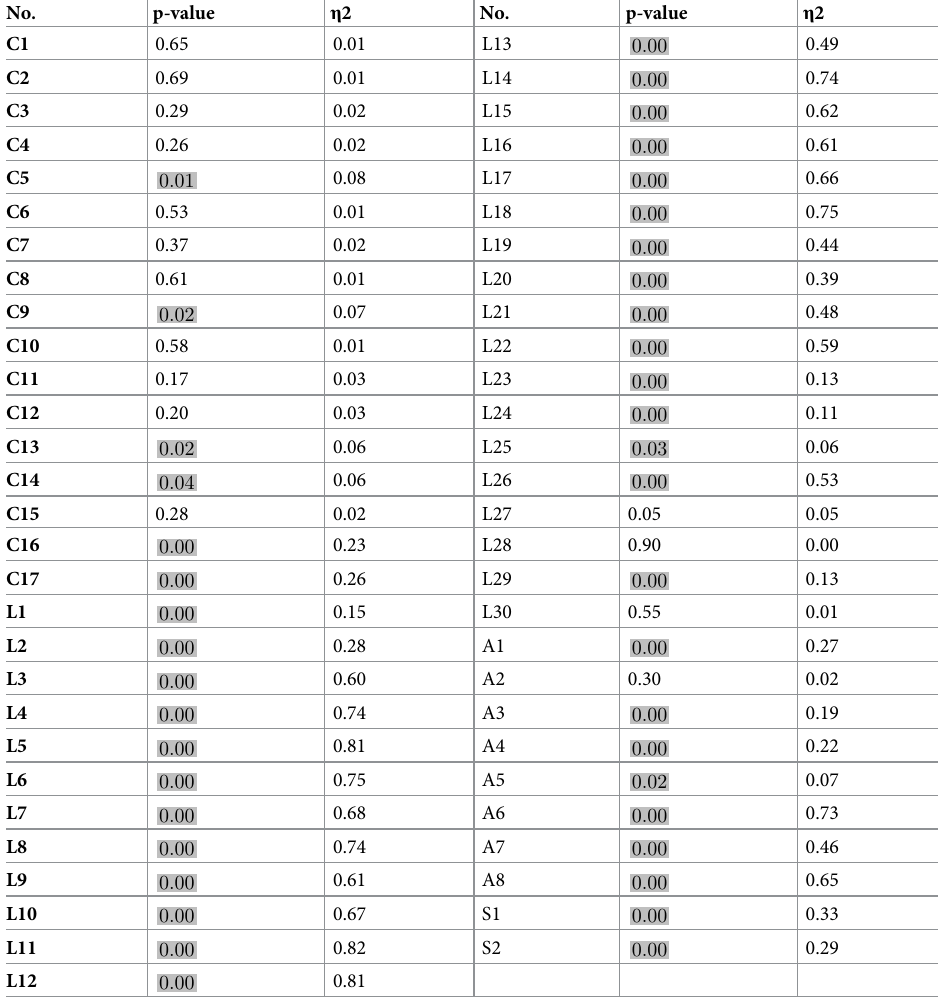
Table 3. Summary of rANOVA results for effect of three postures on each hand measurement (n = 60).